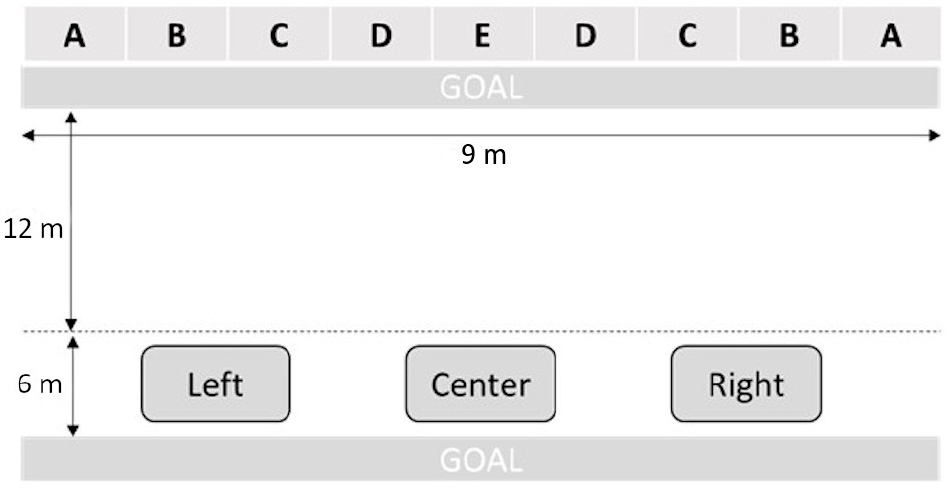
Figure 1. Throwing site (Left, Center, Right) and target areas (A, B, C, D, E) for accuracy